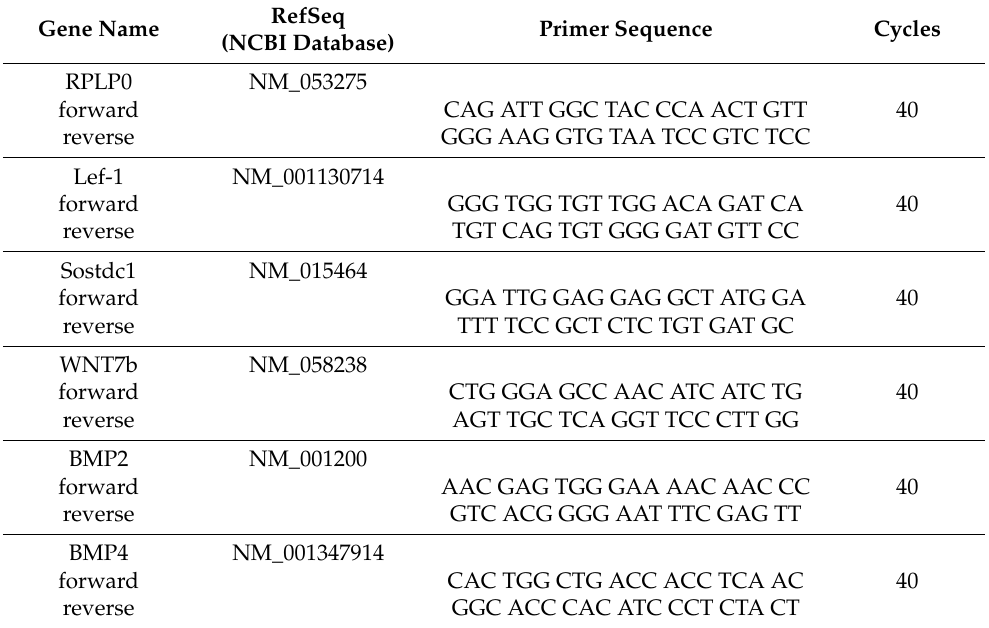
Table 1. Sequences of primers for human